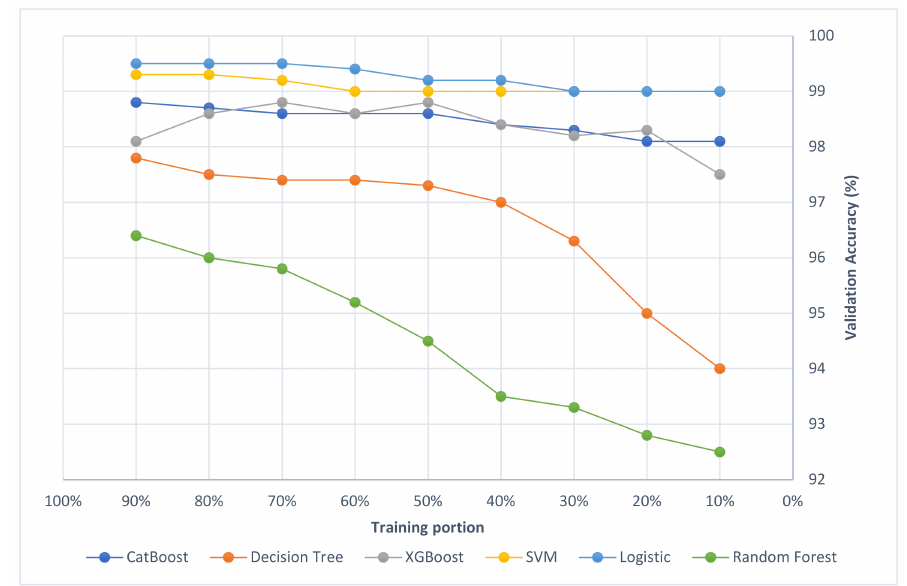
Figure 7. The validation accuracy vs. training